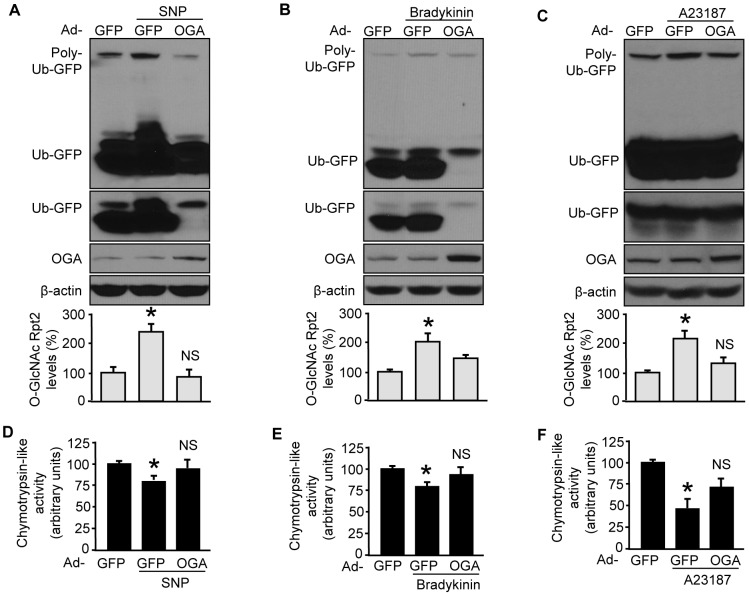
OGA upregulation prevents the suppression of 26S proteasomes induced by NO.Adenoviral overexpression of OGA prevented the proteasome reporter protein accumulation induced by (A) SNP; (B) Bradykinin; and (C) A23187. GOA upregulation via overexpression restored 26S proteasome activity which was otherwise inhibited by (D) SNP; (E) Bradykinin; and (F) A23187. 26S proteasome activity was quantified by measuring chymotrypsin-like activity in the cell lysates. * represent p<0.05 vs control (n = 3). An overlaid portion (less exposure) of each whole blot indicating Ub-GFP is presented. Ad-, Adenoviral overexpression; NS, not significant (v.s. control); OGA, O-GlcNAcase; SNP, sodium nitroprusside; Ub-GFP, ubiquitin-green fluorescent protein.